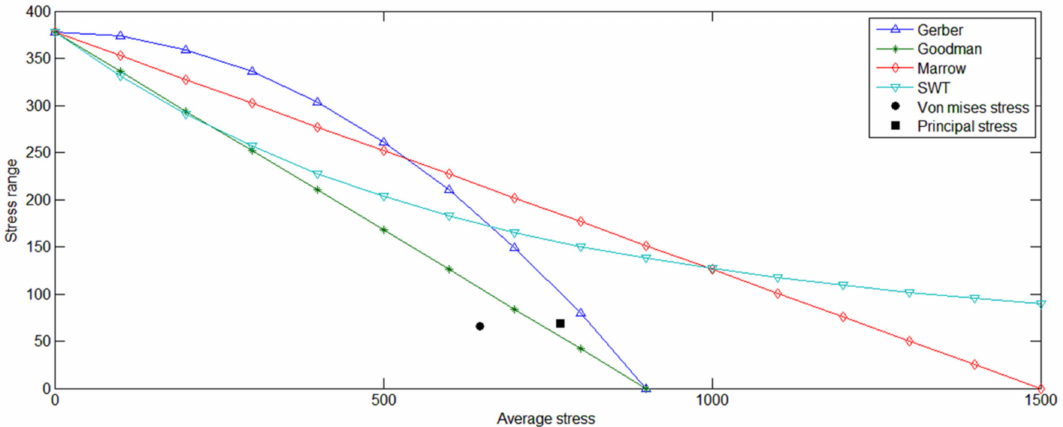
Figure 15. Average stress and stress range in the abutment compared to the theories computed by taking a constant life of N f = 10 6 .